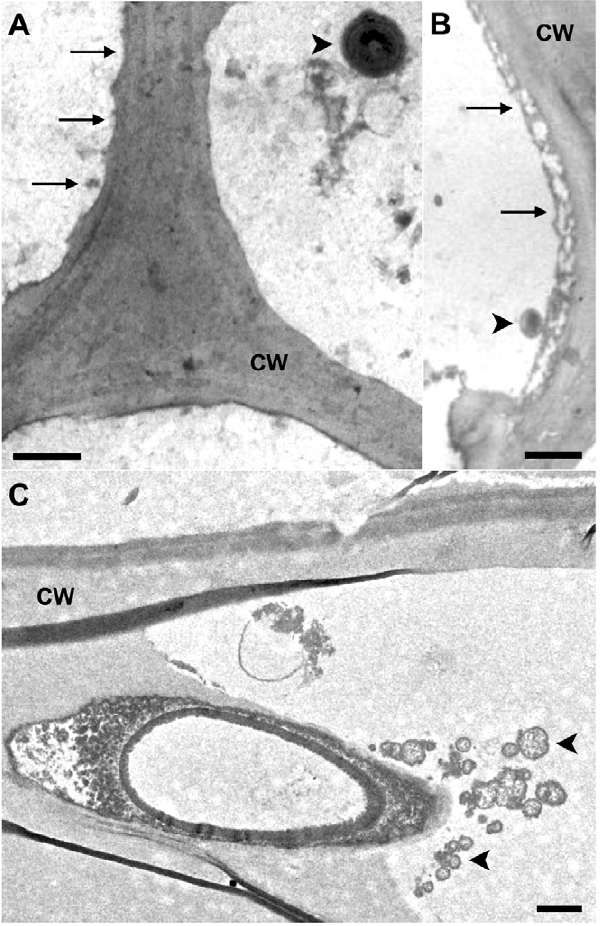
Figure 2. TEM micrographs of composted poplar cell walls. These cell walls display evidence of microbial decay including a scalloped surface (A, B, arrows) and direct microbe attachment to eroded cell wall surfaces (B, C, arrowheads). Scale bars=500 nm. The arrowheads in Figure 2C point to cellulosomes.